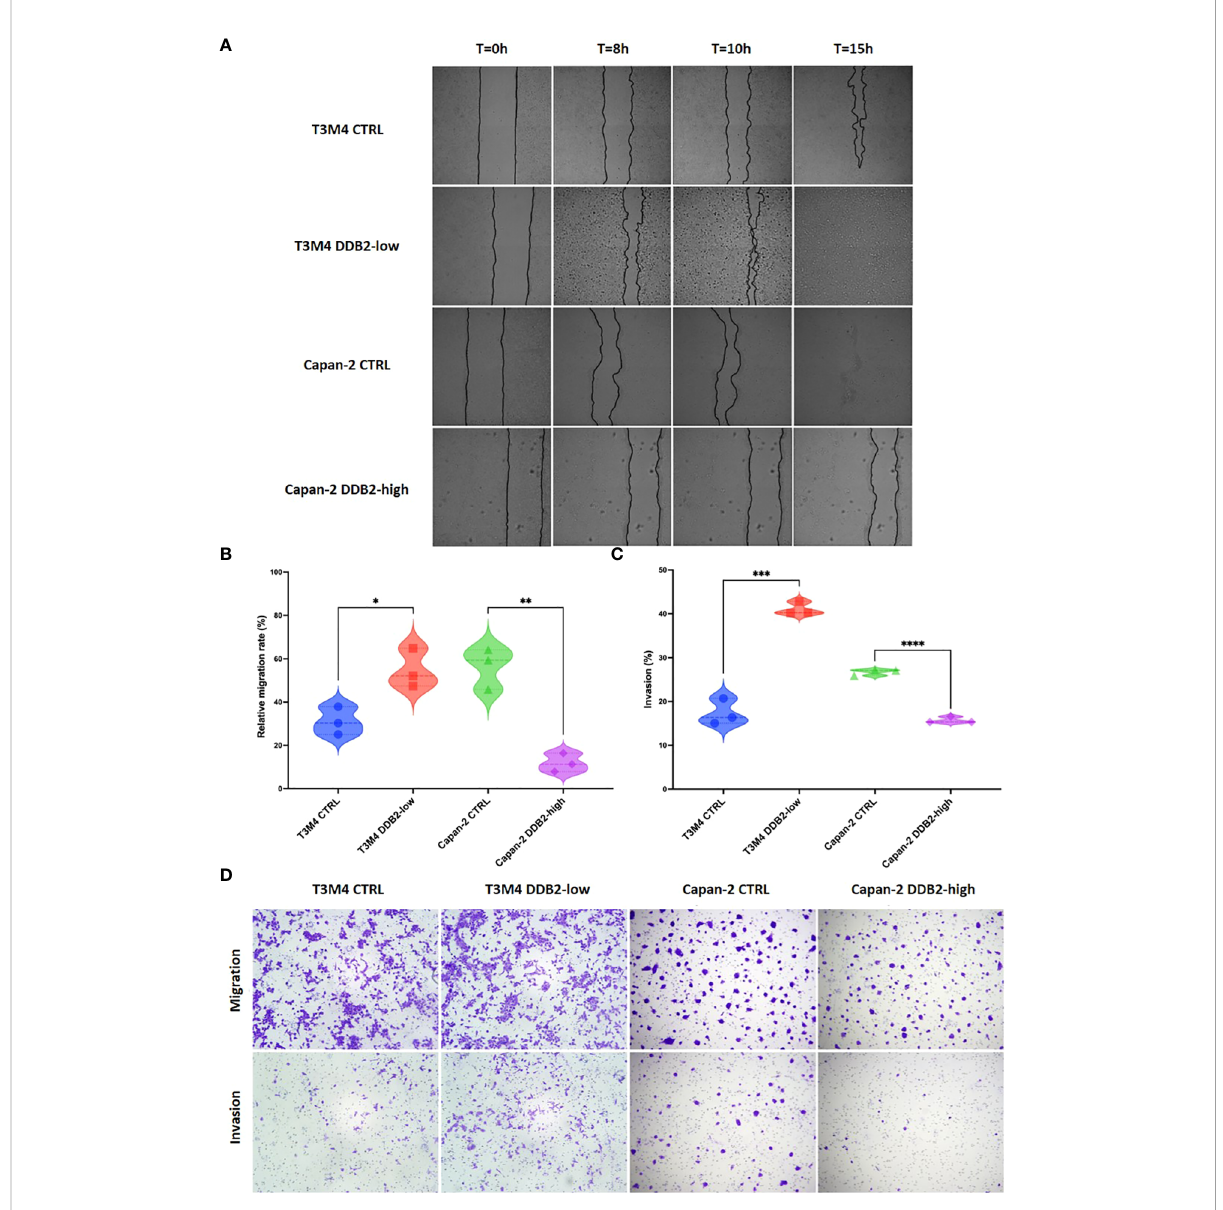
FIGURE 4 Role of the DDB2 protein in the migration and invasion potential of PDAC cell models. (A, B) Analysis of cell migration rate by wound healing assays in T3M4 DDB2-low, T3M4 CTRL, Capan-2 DDB2-high and Capan-2 CTRL cells. Microscopic images of wound healing assays are shown in (A) and the quanti fi cation of relative migration rate at 8h is shown in (B) . Data from 3 independent experiments are expressed as mean ± SEM, *p < 0.05, **p < 0.01 (Student ’ s unpaired t test). (C, D) Analysis of the invasion properties of T3M4 DDB2-low, T3M4 CTRL, Capan-2 DDB2-high and Capan-2 CTRL cells using transwell assays. The quanti fi cation of the percentage of invasion is shown in (C) and microscopic images are shown in (D) . Data from 3 independent experiments are expressed as mean ± SEM, ***p < 0.001, ****p < 0.0001 (Student ’ s unpaired t